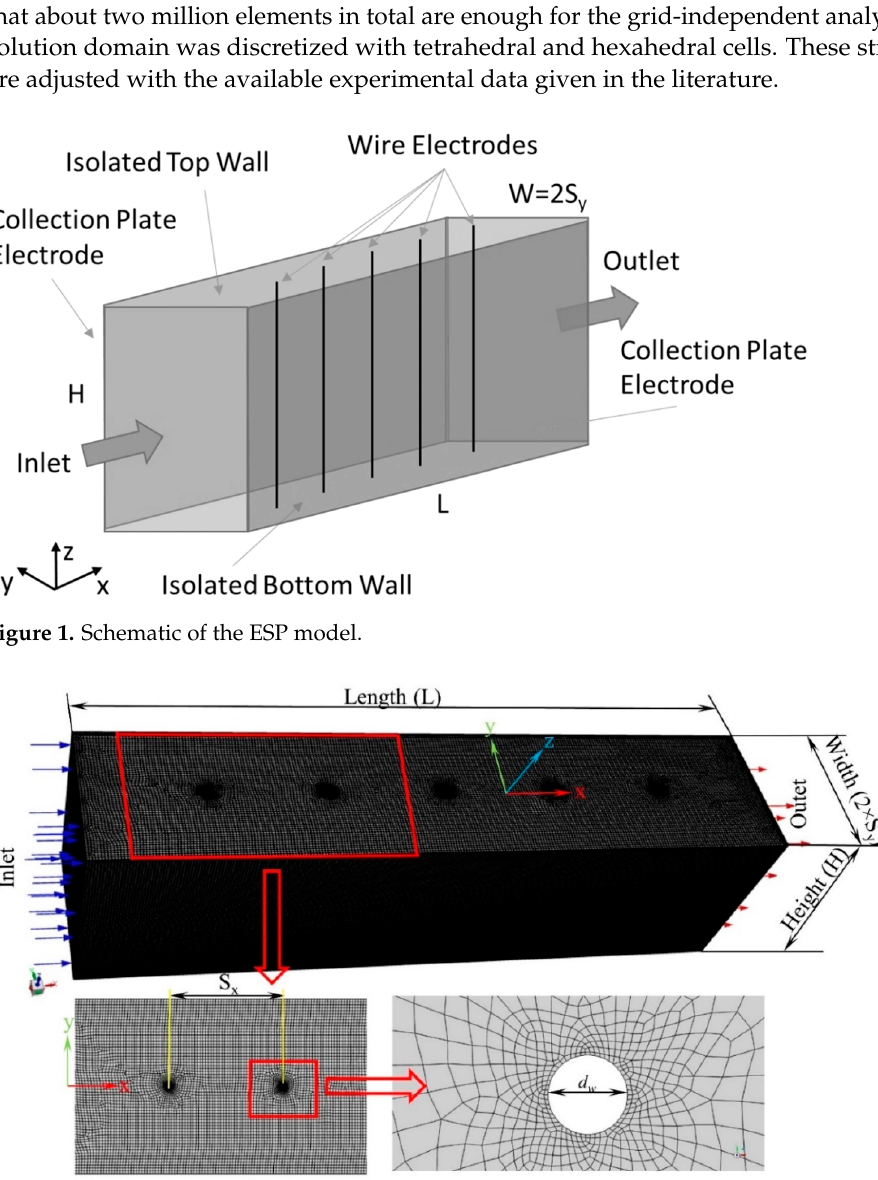
Figure 2. Mesh structure and geometric parameters.